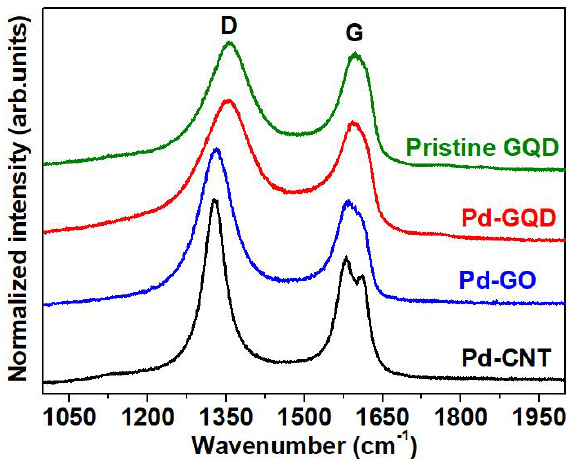
Figure 3. Raman spectra of pristine GQD, Pd-GQD, Pd-GO, and